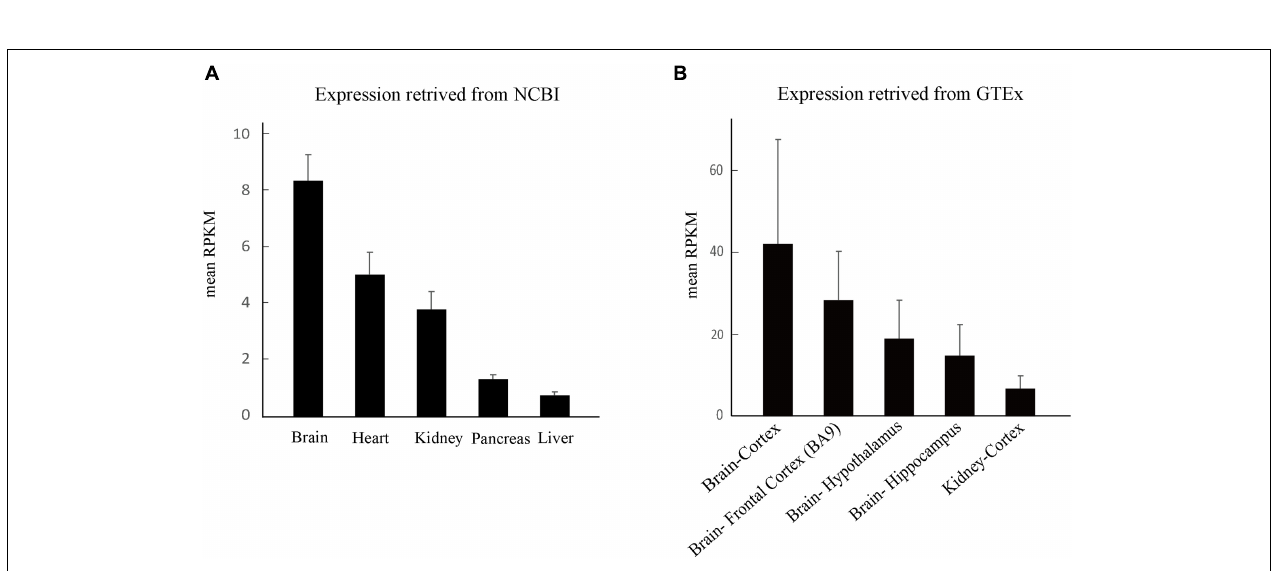
FIGURE 5 | Tissue expression of PKD1 . (A) The overall expression of PKD1 in different tissues retrieved from NCBI. (B) Comparison of PKD1 expression in the sub-regions of human brain and kidney retrieved from GTEx.